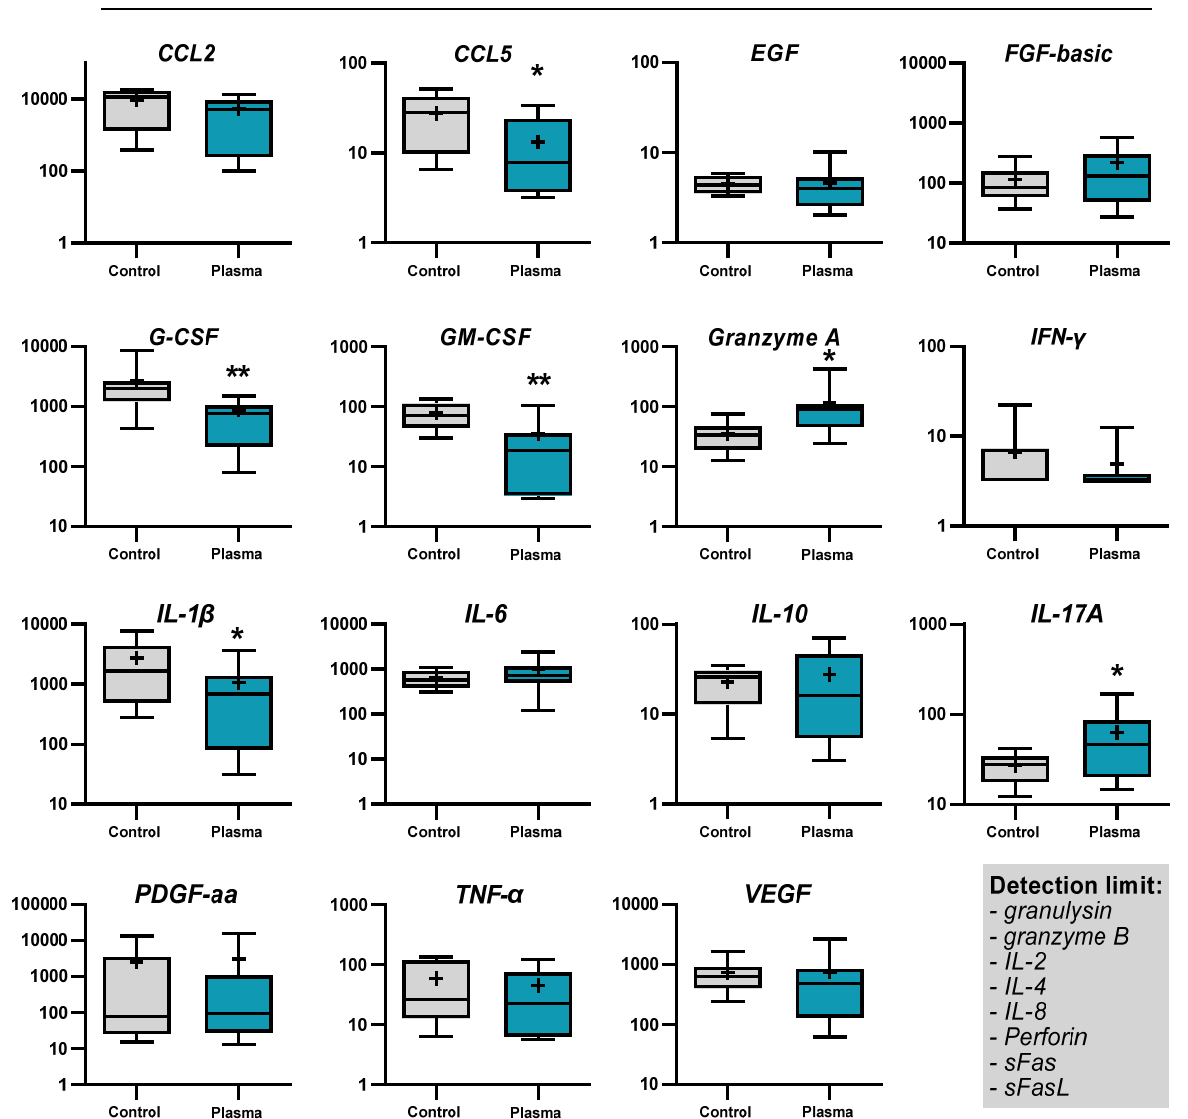
Figure 4. Secretion profile of BCCs: quantification of chemokines, cytokines, and growth factors in pg/mL in BCC tissue culture supernatants 24 h after exposure to gas plasma or argon gas. Data show boxplots from 6–8 patients, and statistical analysis was performed using t -test with p < 0.05 (*) and p < 0.01 (**).